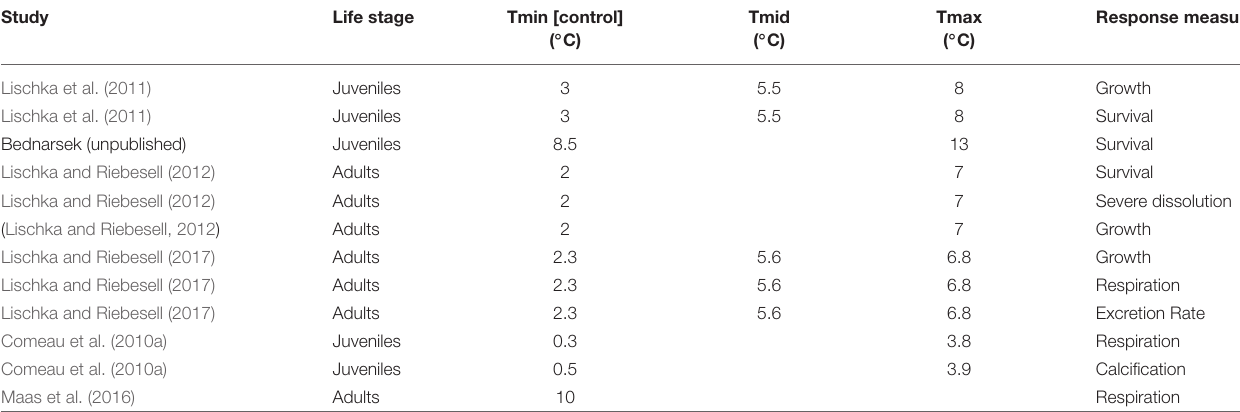
TABLE 2 | Temperatures and response measures of studies used for meta-analysis. Only L. helicina studies have been included. Study Life